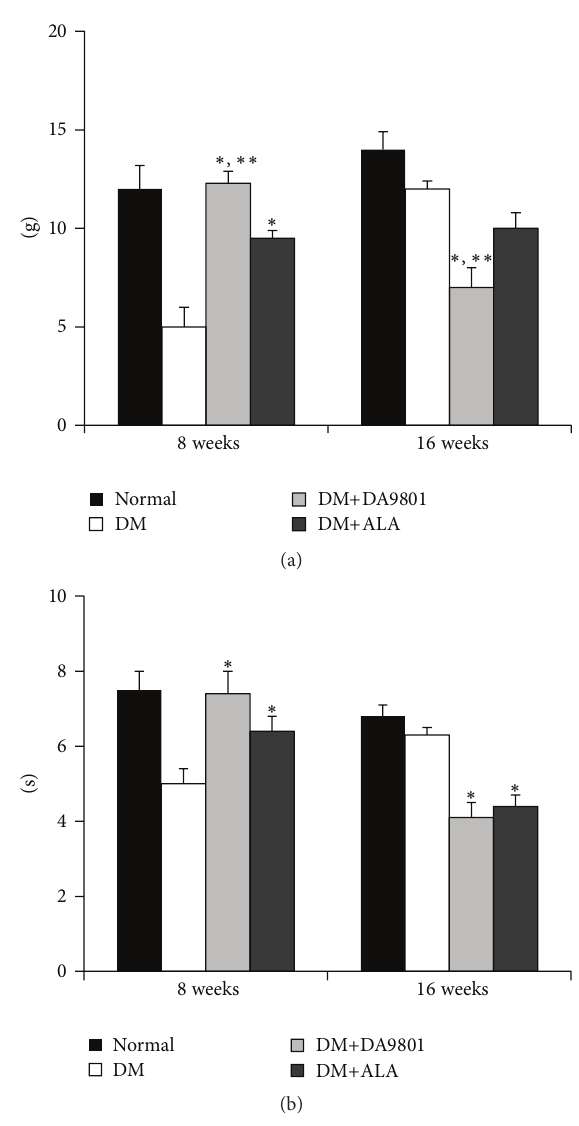
Figure 2: Von Frey filament (a) and hot plate (b) response of the experimental groups. Threshold of tactile response was lower in the nontreated diabetic group as compared with the DM+DA-9801 or DM+ALA groups on the 8th week. On the 16th week, however, this trend was reversed, and the thermal response was also changed in a similar pattern to the tactile response. Data are presented as means ± SD. ∗ 𝑃 < 0.05 versus Normal and ∗∗ 𝑃 < 0.05 versus DM ( 𝑁 = 10 in each group). ALA: Alpha lipoic acid and DM: